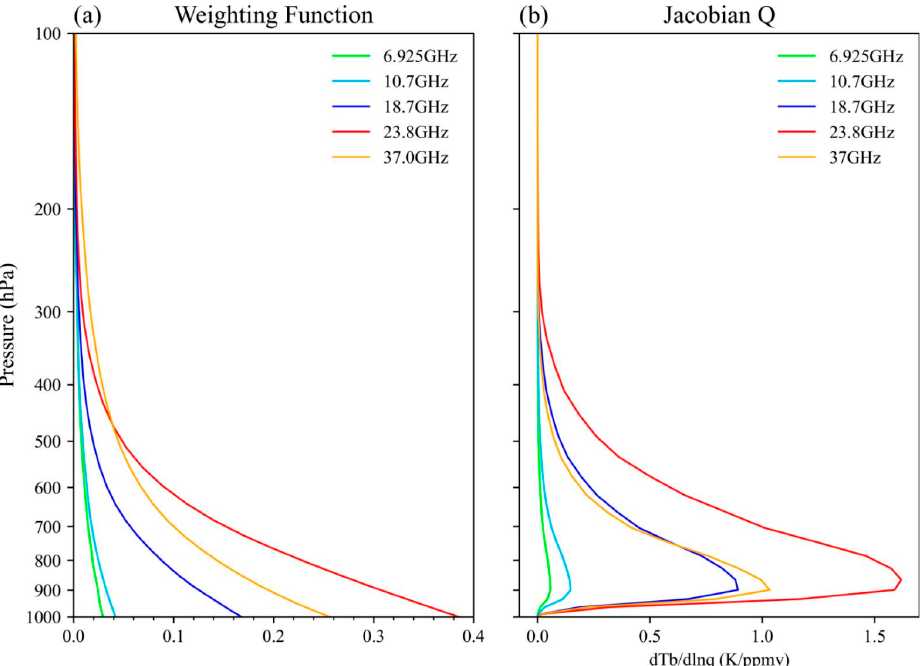
Figure 2. ( a ) Weighting functions and ( b ) humidity Jacobian functions for HY-2B SMR. The atmospheric profile comes from the U.S. standard atmosphere. The adopted rapid radiative transfer model is the Radiative Transfer for TOVS (RTTOV) ver.12.3.